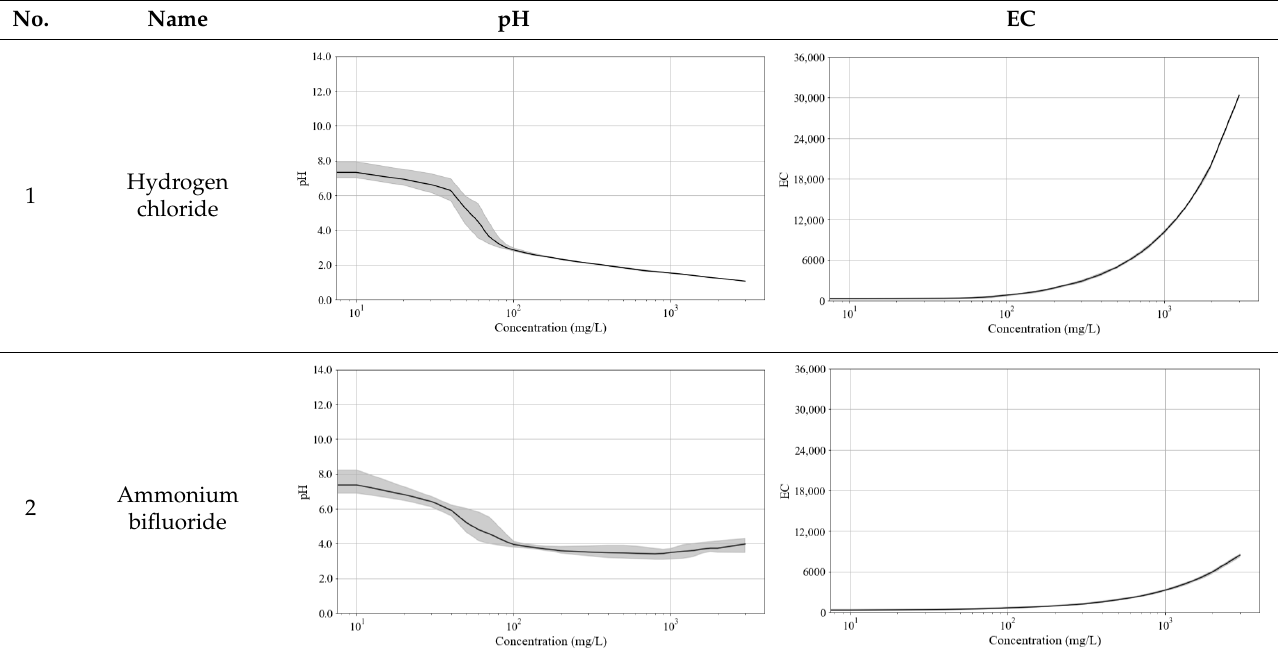
Table A1. Variation in pH and EC with concentration for several chemicals in surface water samples (log scale).